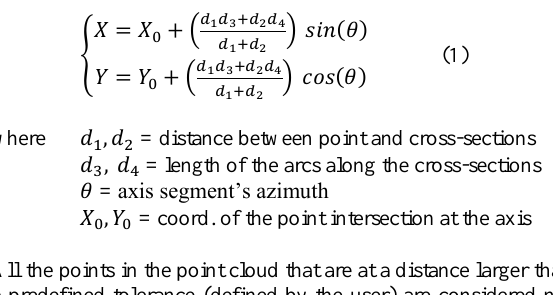
Figure 9. The two sections (at 25% (green) and 75% (orange) of the segment length) and the respective points.